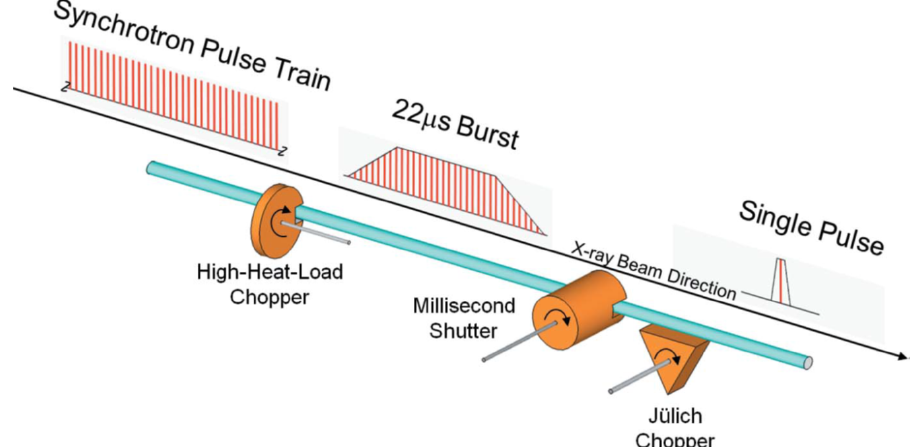
Figure 3. Schematic single-pulse isolation protocol implemented at the 14-ID-B BioCARS beamline at APS. Figure reproduced with permission of the International Union of Crystallography from Graber et al. [54].